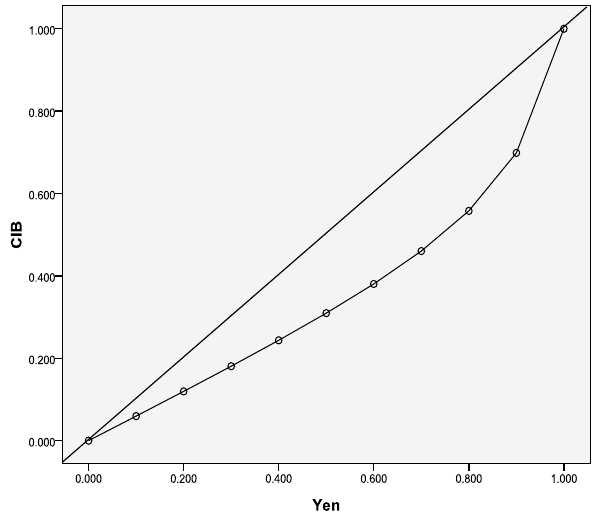
Figure 2. Relationship between Youden index (J) and comprehensive index of biomarker (CIB) (incidence = 0.05). CIB showed an unsteady increase with J for low-probability events.